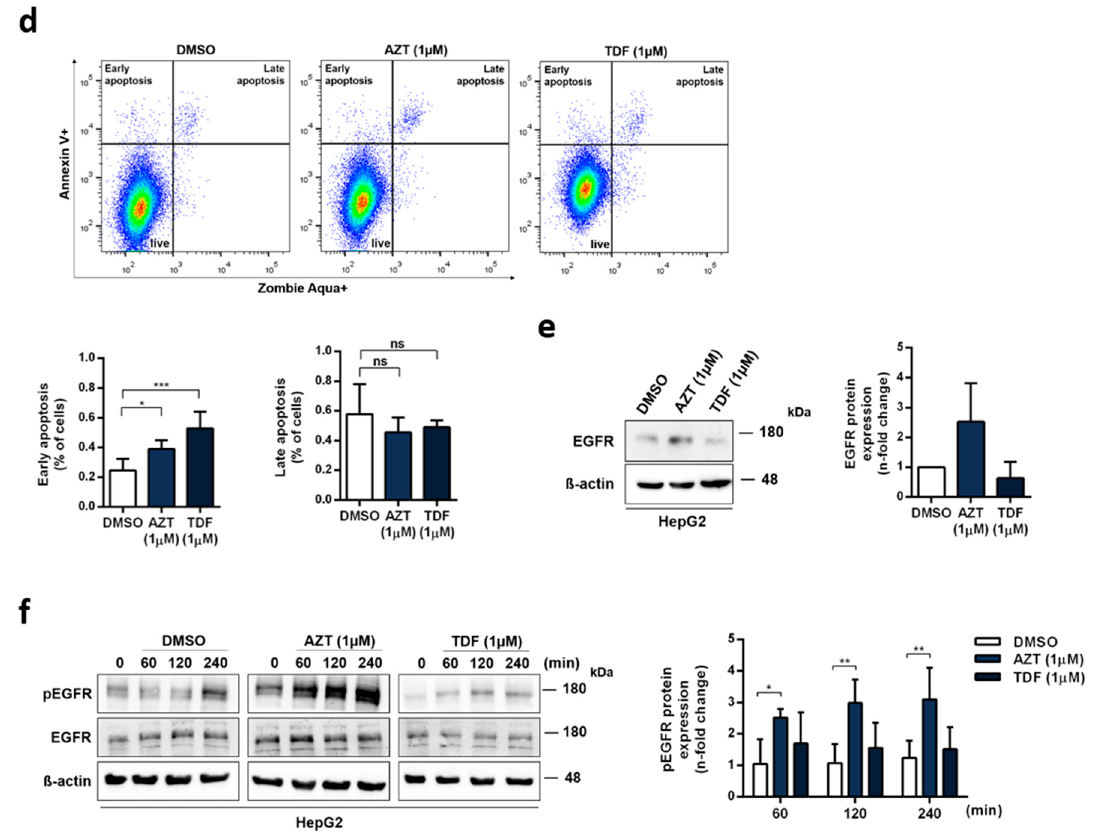
Figure 6. E ff ect of di ff erent nucleotide analogues on alteration in the cell phenotype and activation of EGFR. ( a ) Cytotoxicity of zidovudine (AZT) and tenofovir (TDF) in HepG2 cells was detected by Rotitest ® Vital. Bar graph displays absorbance as a fold change in relation to DMSO. ( b ) Cell cycle analysis of HepG2 cells treated with AZT and TDF. ( c ) Apoptosis induction was evaluated with Annexin V and live / dead cell staining by flow cytometry. ( d ) Proliferation rates were determined by trypan blue exclusion and displayed in relation to DMSO. ( e ) EGFR expression after four days of continuous treatment with AZT and TDF. One representative immunoblot is shown. Bar graph presents relative quantification of EGFR as a fold change compared to DMSO. ( f ) Activation of EGFR after AZT and TDF therapy was evaluated by immunoblot analysis at di ff erent time points. One representative immunoblot is depicted. pEGFR expression is shown as a fold change in relation to time point 0. All graphs present mean + s.d. from three independent experiments. Statistical significance was determined through one-way ANOVA ( a , c , d ) and two-way ANOVA ( b , f ). ns: not significant; * p ≤ 0.05; ** p ≤ 0.01; *** p ≤